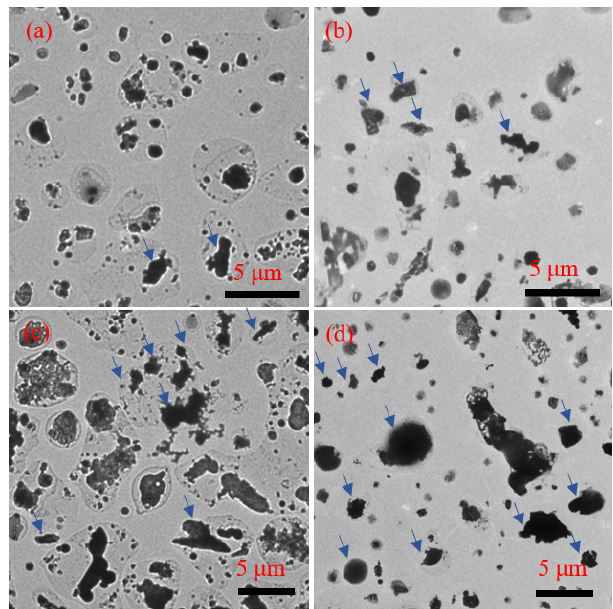
Figure 5. Low-magnification images of individual particles. Panels (a) and (c) are particles above the mixed-layer height (MLH) at dif- ferent size ranges. Panels (b) and (d) are particles at ground level at different size ranges. More coated particles were found above the MLH. Arrows show part of the mineral